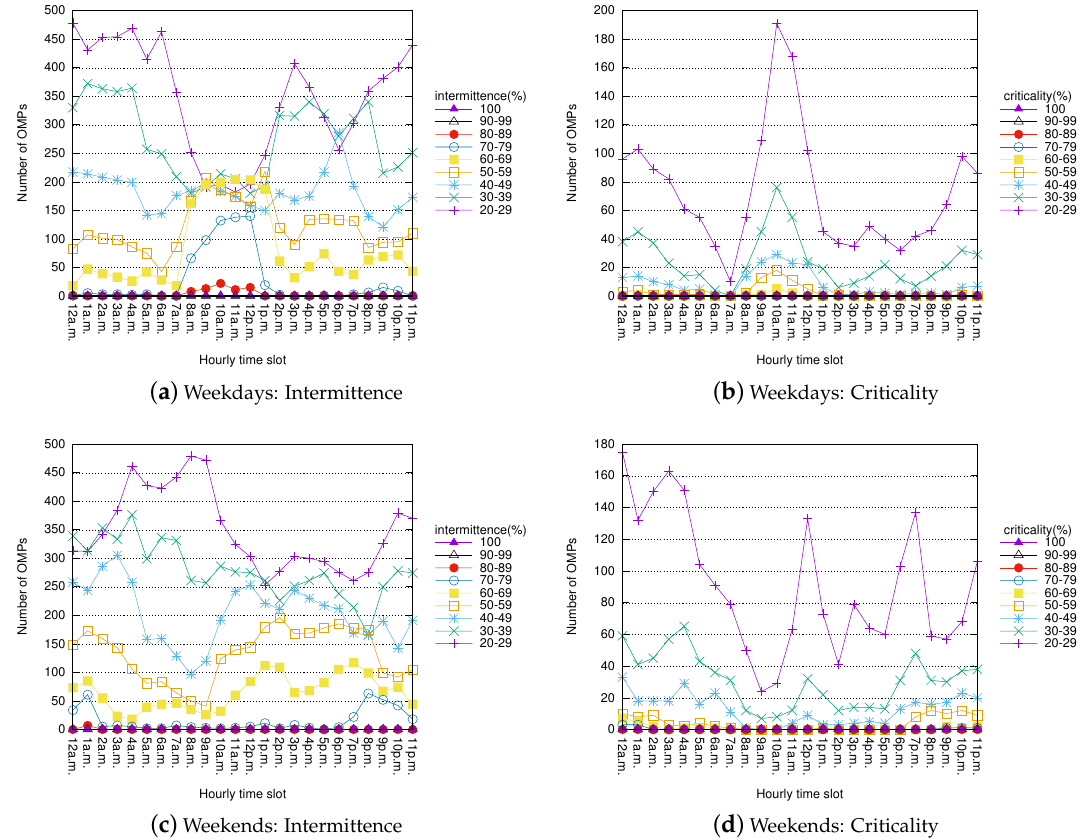
Figure 11. Barcelona. Characteristics of the mined OMPs related to weekdays and weekends. full-th = 3. time slot size = 1